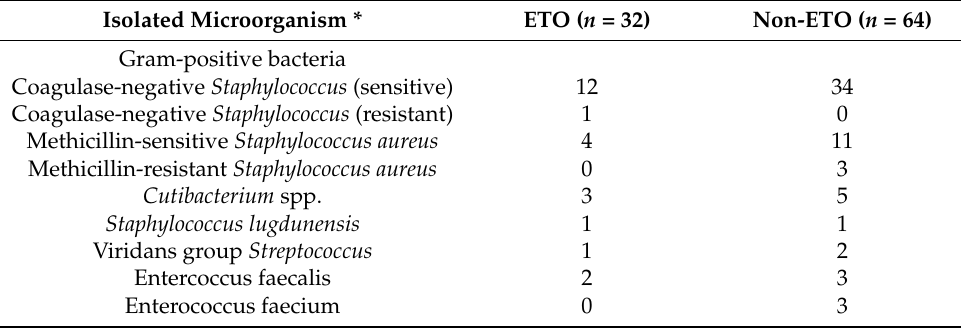
Table 2. Comparison of microorganism frequency between ETO and non-ETO